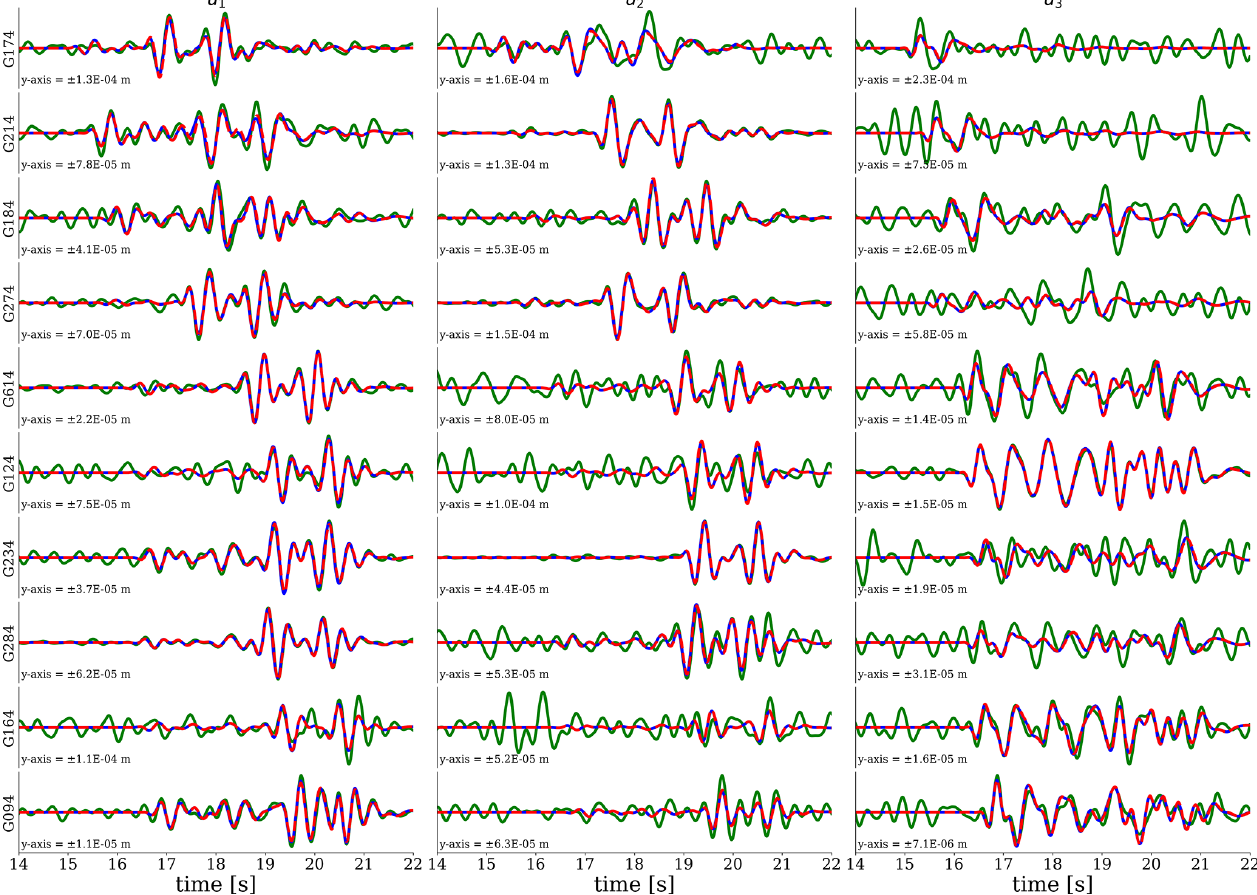
Figure 9. Comparison between the true seismograms (red), observed (true + noise) seismograms (green), and seismograms generated using the final posterior mean